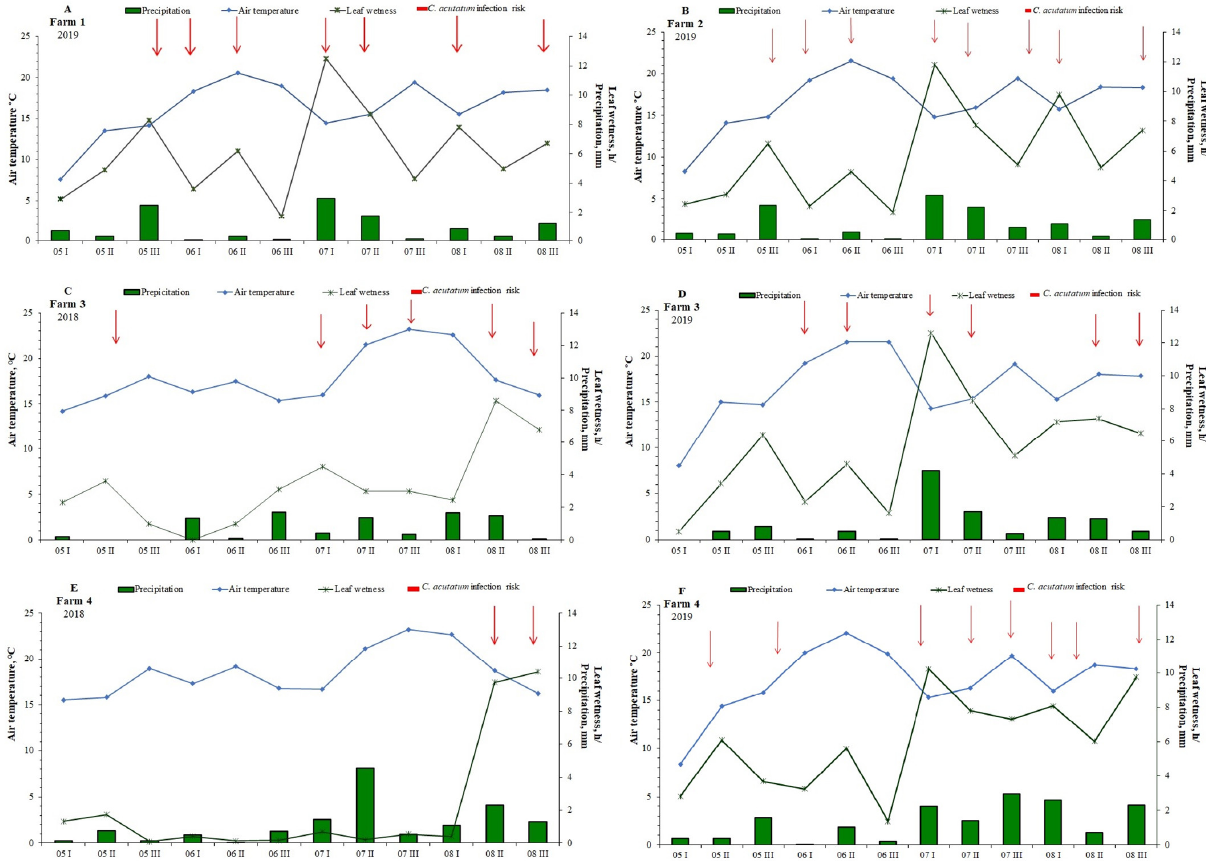
Figure 1. The meteorological conditions according to iMETOS ® meteorological stations (( A ) Farm 1 in 2019; ( B ) Farm 2 in 2019; ( C ) Farm 3 in 2018; ( D ) Farm 3 in 2019; ( E ) Farm 4 in 2018; ( F ) Farm 4 in 2019). Data are presented as an average.